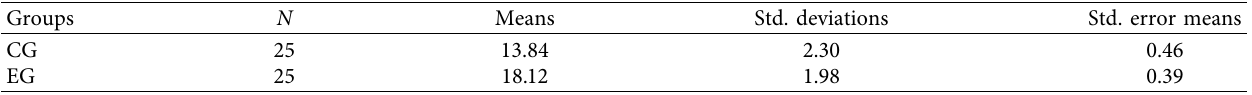
Table 3: Means and standard deviations of both groups on the immediate vocabulary posttest.